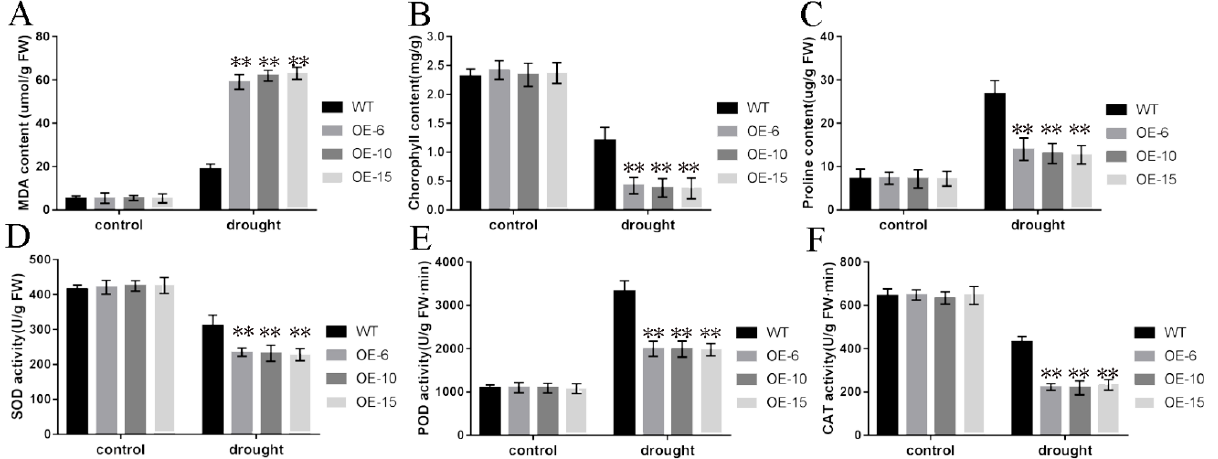
Figure 5. Physiological indexes determined in TaNBR1 -overexpressing Arabidopsis transgenic plants and wild-type controls after drought treatment. ( A ) Malondialdehyde content. ( B ) Chlorophyll con- tent. ( C ) Proline content. ( D ) Superoxide dismutase (SOD) content. ( E ) Peroxidase (POD) activity levels. ( F ) Catalase (CAT) activity levels measured before and after drought stress. Each data point is the average based on at least three replicates, ** t -test, p < 0.01.